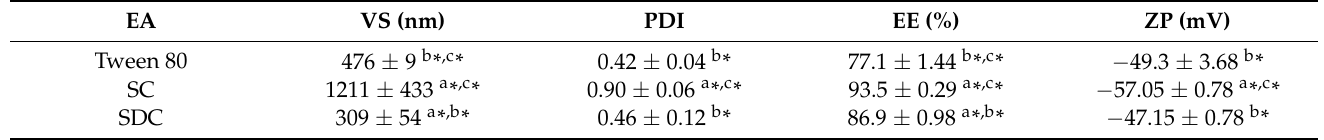
Table 1. Mean ( ± SD) vesicle size (VS), polydispersity index (PDI), % entrapment efficiency (EE%) and